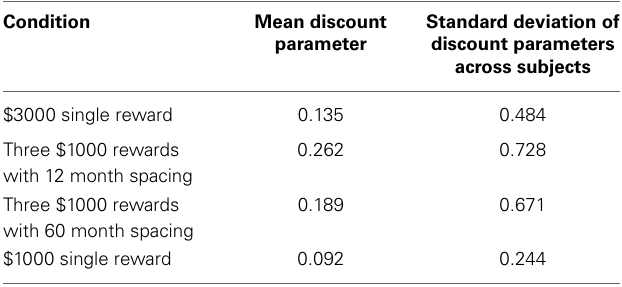
Table 3 | Summary statistics of the best-fitting discount parameters for Parallel model in each condition.